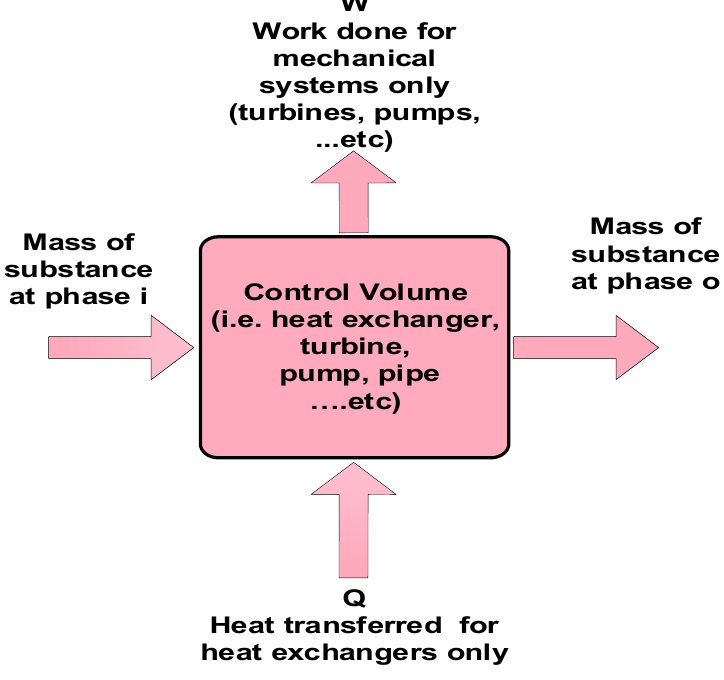
Figure 3. The control volume.